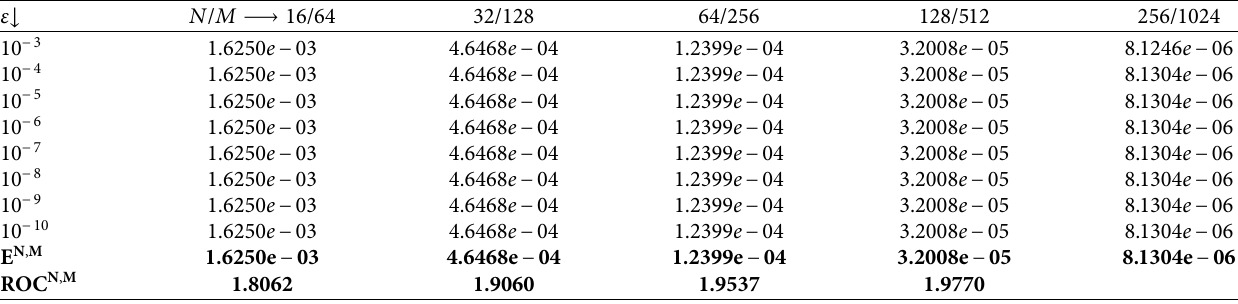
Table 2: Computed maximum point-wise errors, ε -uniform errors ( E N,M ) , and the ε − uniform rate of convergence ( ROC N , M ) for Example 1, after extrapolation.